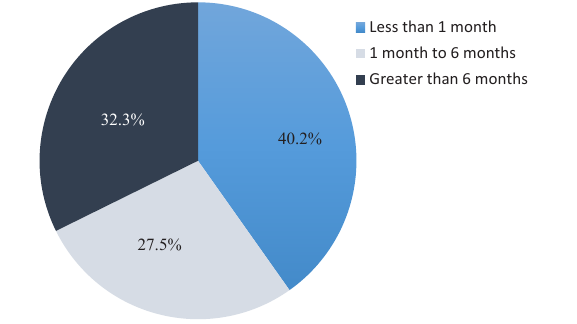
Figure 2. Participants’ Duration of